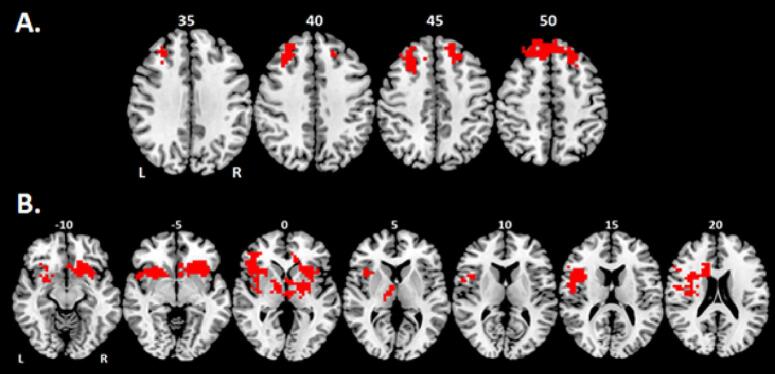
Axial slices showing whole brain linear correlation between brain activation in the baseline stop task (successful stop - go trials) and self-regulation learning scores of A) rIFC activation in the rIFC-NF group and of B) lPHG activation in the lPHG-NF group; both at false positive error-corrected voxel-level p < 0.05, and cluster-level p < 0.005 (yielding < 1 false positive cluster per map). The brain clusters in red correspond to the significant positive correlation between stop-task related brain activation across the whole brain and fMRI-NF learning. There were no significant negative correlations between stop task-related brain activation and fMRI-NF learning in either of the two groups. The right side of the image corresponds to the right side of the brain. Axial slices are shown in mm distance from the anterior-posterior-commissure. (For interpretation of the references to colour in this figure legend, the reader is referred to the web version of this article.)